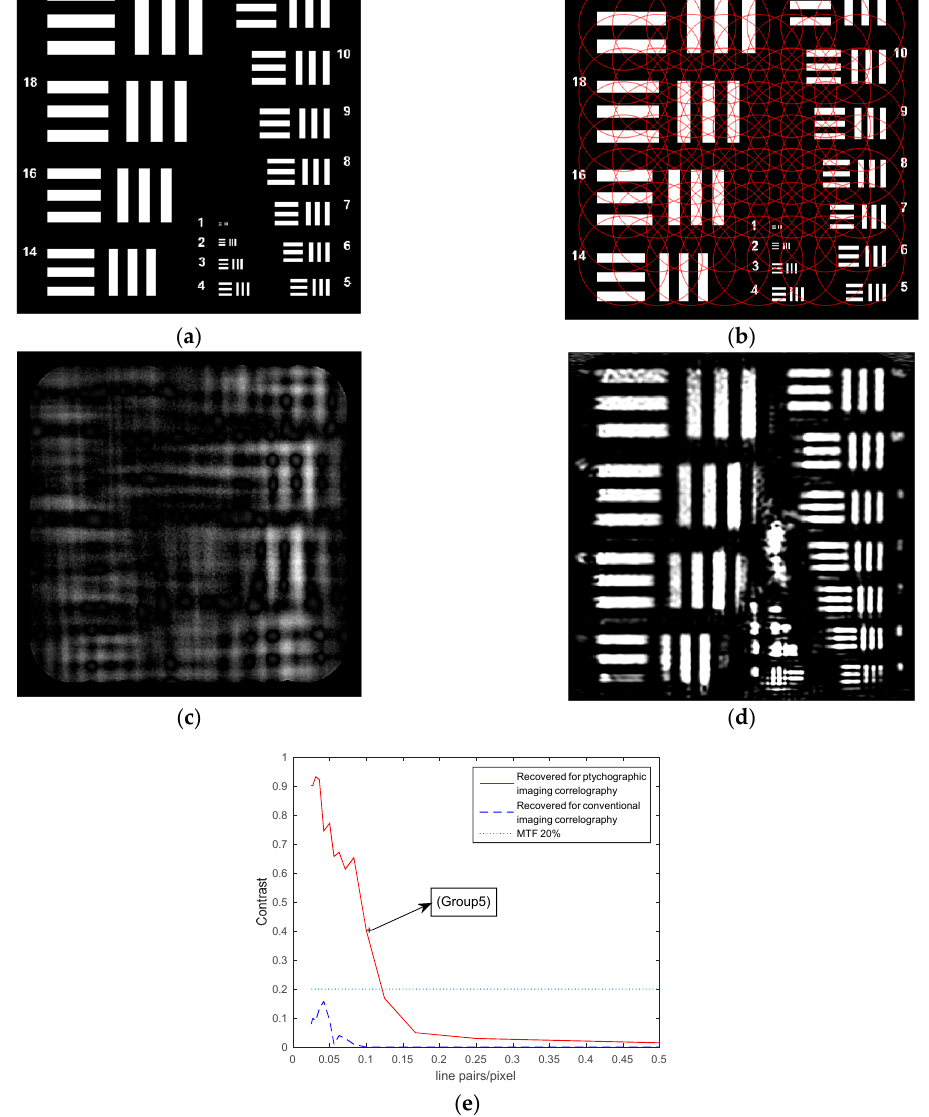
Figure 8. ( a ) Ground truth resolution chart. ( b ) Ptychographic measurements for the resolution chart. ( c ) Recovered image for conventional imaging correlography. ( d ) Recovered image for ptychographic imaging correlography. ( e ) The contrast of the groups in the recovered images.